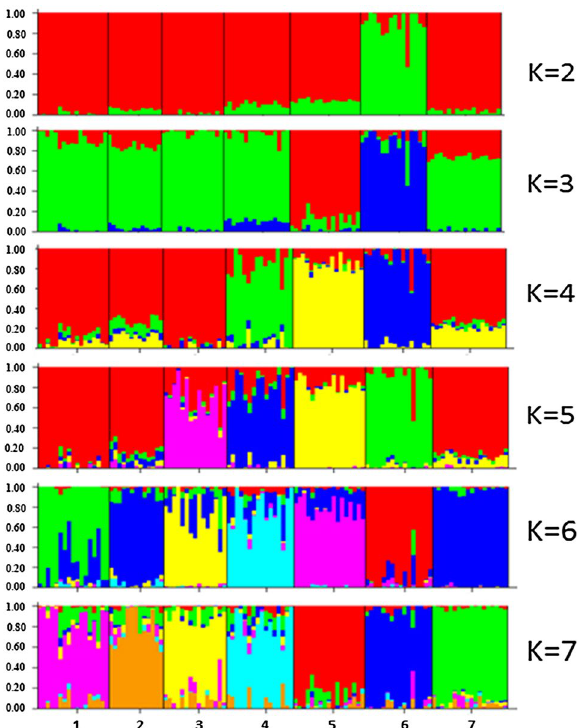
Figure 5. Population structure of seven Indian cattle breeds inferred by using the STRU CTU RE software. Each animal is represented by a single vertical line divided into K colors, where K is the number of assumed ancestral clusters, that ranged from 2 to 7, the color segments shows the individual’s estimated membership proportions in a given clusters: Breed abbreviations are defined as below:1. Tharparkar, 2. Sahiwal, 3. Gir, 4. Vechur, 5. Ongole, 6. Kangayam, 7. Hariana.